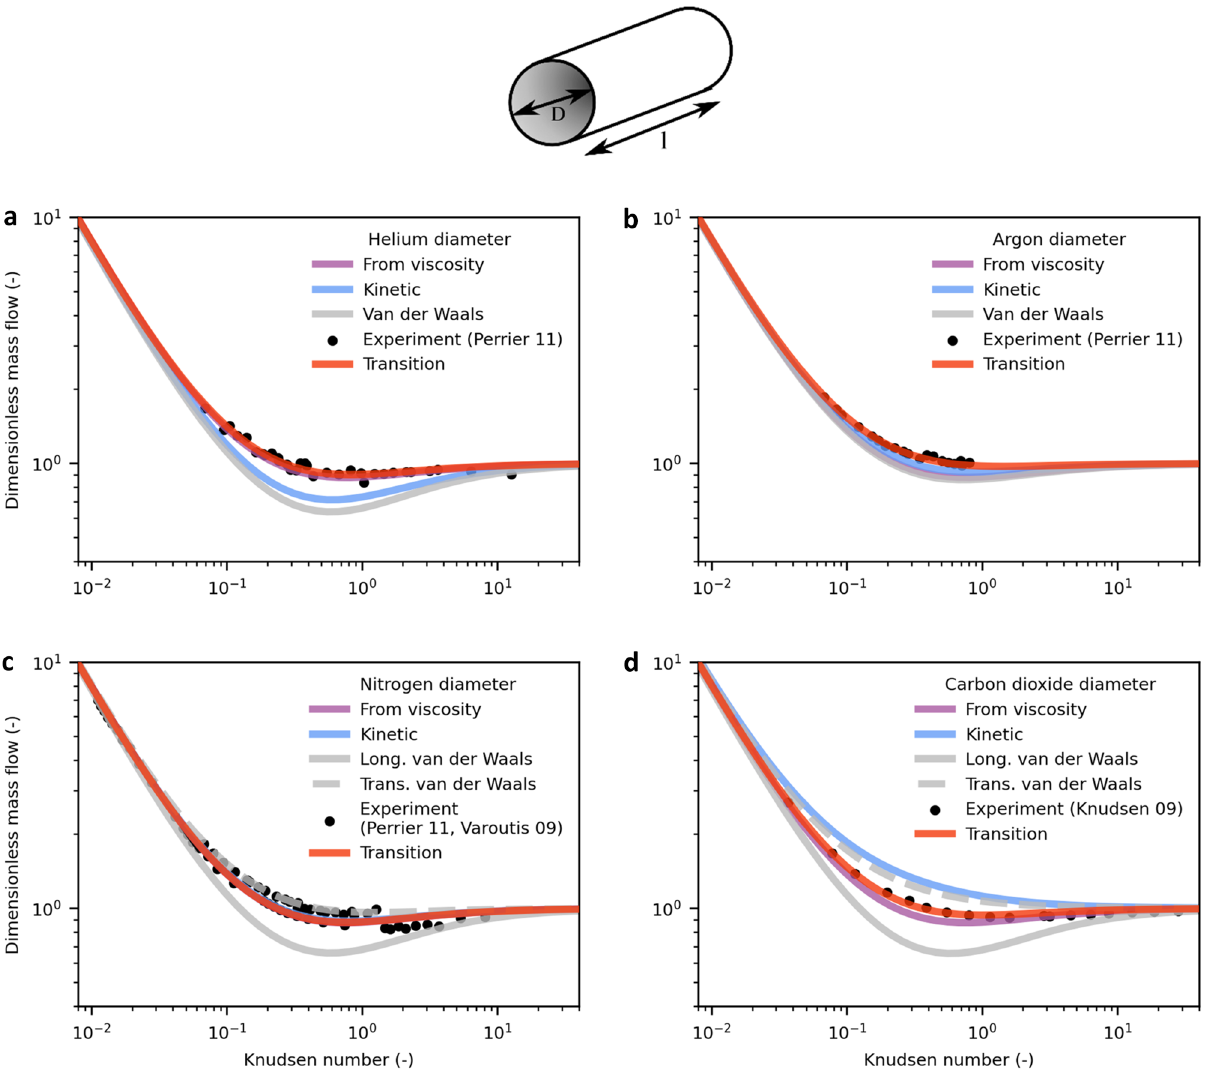
Figure 3. Mass flow in circular channels modelled with different molecular diameters compared to experimental data obtained from the literature. Dimensionless mass flow of helium 32 ( a ), argon 32 ( b ), nitrogen 32,33 ( c ) and carbon dioxide 22 ( d ) predicted by the model. The transition diameter is determined by least squares fitting to Eqs. (2)–(6). For comparison, the results for calculations using established molecular diameters from the literature are shown. For the nonspherical molecules nitrogen and carbon dioxide, two different van der Waals diameters are given for the transversal and longitudinal orientation,